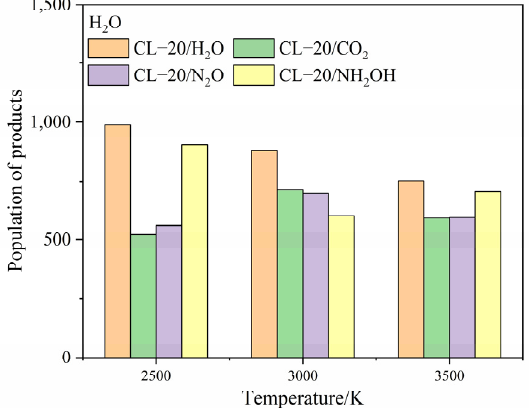
Figure 13. The population of H 2 O after the complete decomposition reaction for CL-20/H 2 O, CL- 20/CO 2 , CL-20/N 2 O, CL-20/NH 2 OH at 2500 K, 3000 K and 3500 K. The population of CO 2 for CL-20/NH 2 OH and CL-20/H 2 O are nearly equivalent at high temperatures. The population of CO 2 for CL-20/N 2 O is the lowest, while the popula- tion of CO 2 for CL-20/H 2 O is largest at 2500 K. As the temperature increase, the more pop- ulation of CO 2 for CL-20/N 2 O grows acutely. However, the population of CO 2 for CL- 20/CO 2 , CL-20/NH 2 OH decrease acutely. It demonstrates that the CO 2 -produced mecha- nism for a N 2 O guest is different with CO 2 and NH 2 OH guests. The populations of N 2 for CL-20/NH 2 OH and CL-20/H 2 O are nearly equivalent at high temperatures. As the tem- perature increases, the more the population of CO 2 for CL-20/CO 2 , CL-20/N 2 O grows acutely. It demonstrates that the N 2 -produced mechanism for NH 2 OH guest is different with CO 2 and N 2 O guests. The populations of H 2 O for CL-20/NH 2 OH and CL-20/H 2 O are nearly equivalent at high temperatures. The populations of H 2 O for CL-20/CO 2 and CL- 20/N 2 O are nearly equivalent at high temperatures. The varying tendency of population for the three main products shows that the influence of guest NH 2 OH and H 2 O, CO 2 and N 2 O are much same to each other. This may be caused by the hydrogen for two guest groups. 2.4.2. Effect of Nitrogen-Guest on the k 3 The final products of thermal decomposition of CL-20/guest are N 2 , CO 2 and H 2 O. The formation rates k 3 can be obtained by fitting the variation trend of the final products with the exponential function [34]: C ( t ) = C ∞ {1 − exp[ − k 3 ( t − t i )]}, where C ∞ is the asymptotic number of the product, k 3 is the formation rate constant of the product, and t i is the time of appearance of the product. Comparison of the k 3 values of CO 2 , H 2 O and N 2 for the (a) CL-20/H 2 O, (b) CL-20/CO 2 , (c) CL-20/N 2 O, (d) CL-20/NH 2 OH at different temperatures is shown in Figure 14. All the k 3 values of CO 2 , H 2 O and N 2 are increased as the temperature improvement. This may be due to the facilitation on production the three main products. The k 3 value of H 2 O is larger than that of N 2 , while the k 3 value of N 2 is larger than that of CO 2 for CL-20/H 2 O, CL- 20/CO 2 , CL-20/N 2 O, CL-20/NH 2 OH. This demonstrates that the production of H 2 O is the easiest and the production of CO 2 is the most difficult.